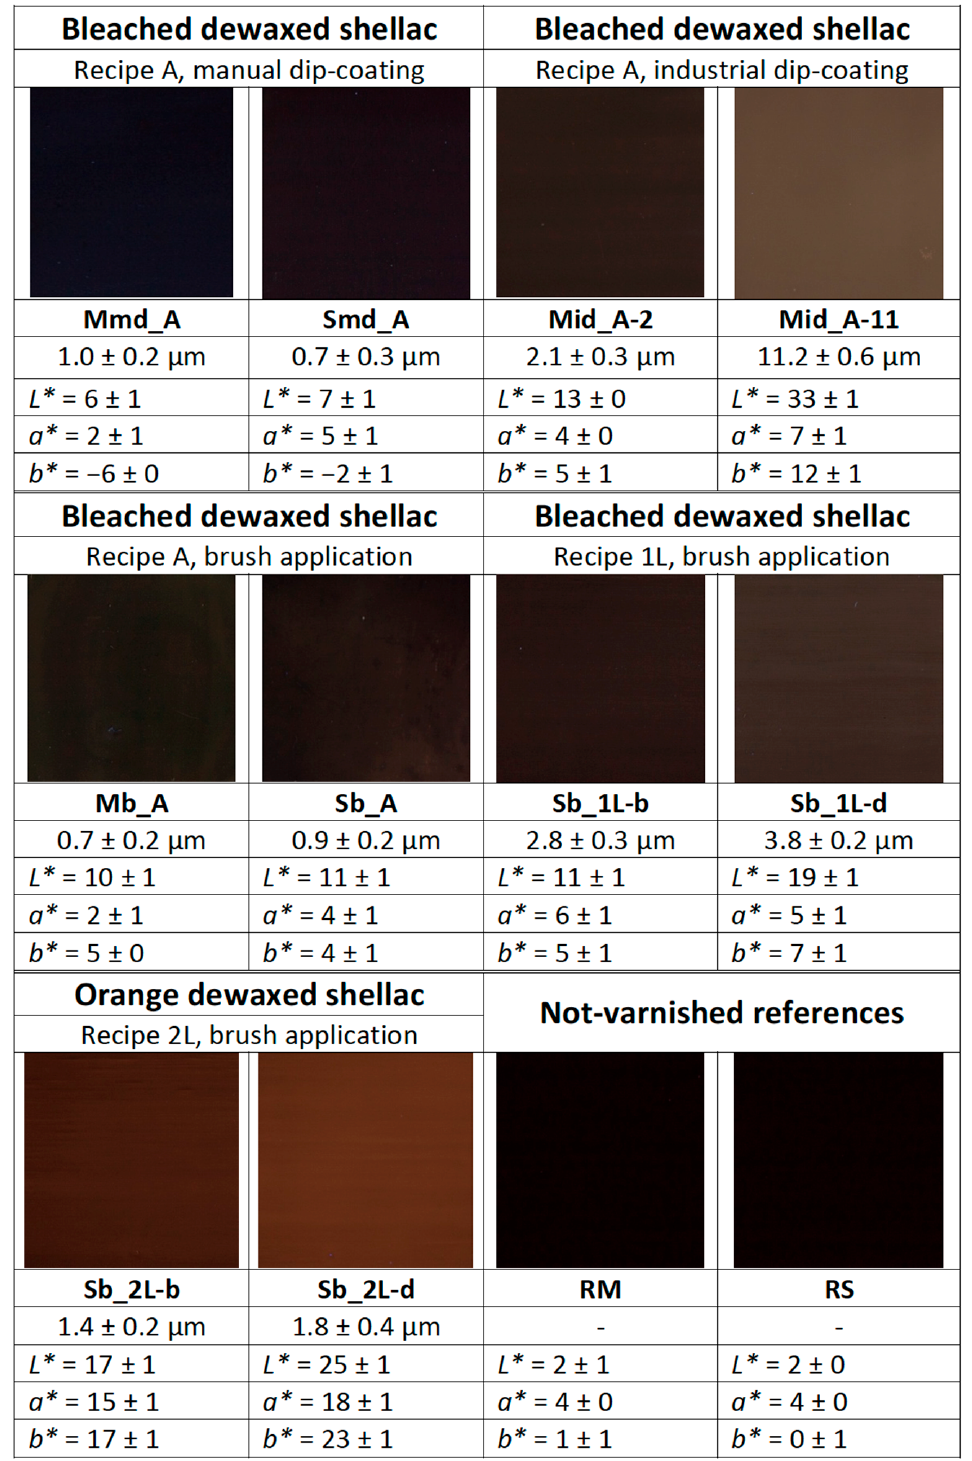
Figure 3. Results of the UV imaging and the colorimetric analysis performed on varnishes with different thicknesses and on different supports.